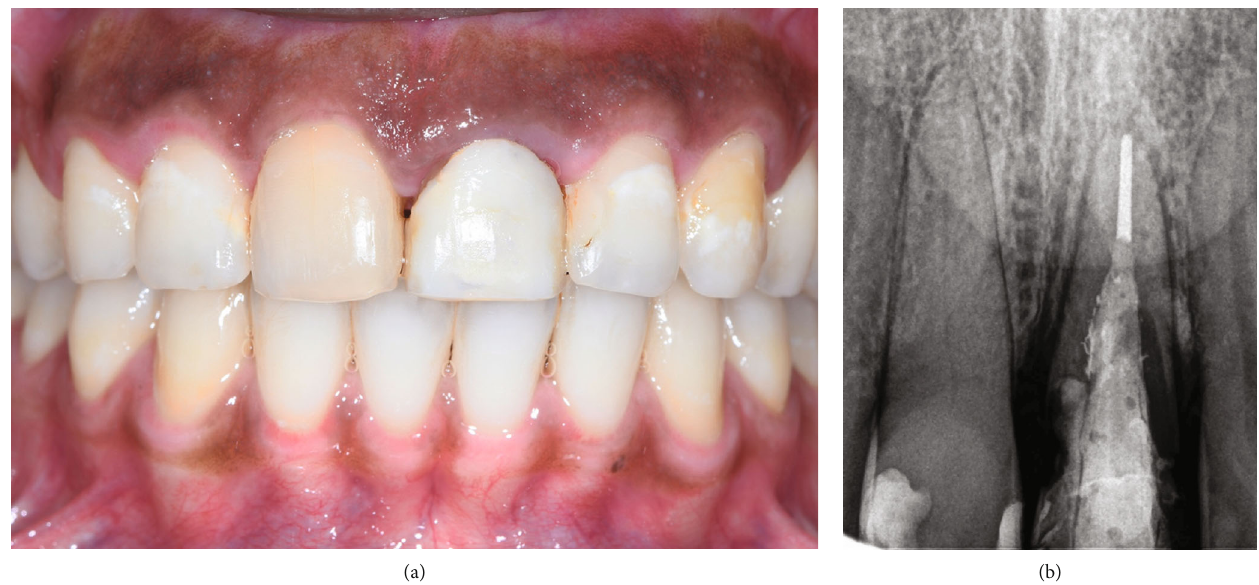
Figure 3: Clinical and radiographic presentation after orthodontic extrusion of tooth 21. (a) Intraoral frontal view showing the coronal relocation of the gingival margin and preservation of interdental papillae. (b) Periapical radiograph showing the coronal repositioning of the apex of the tooth and bone fi ll proximally.